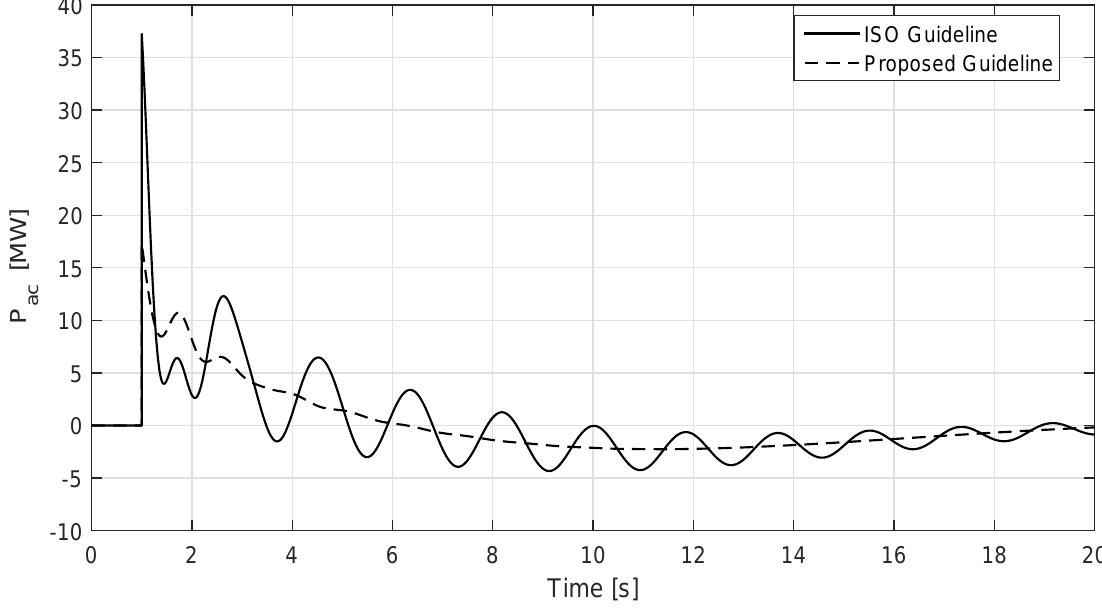
Figure 10. Accelerating power response for the power plant at bus